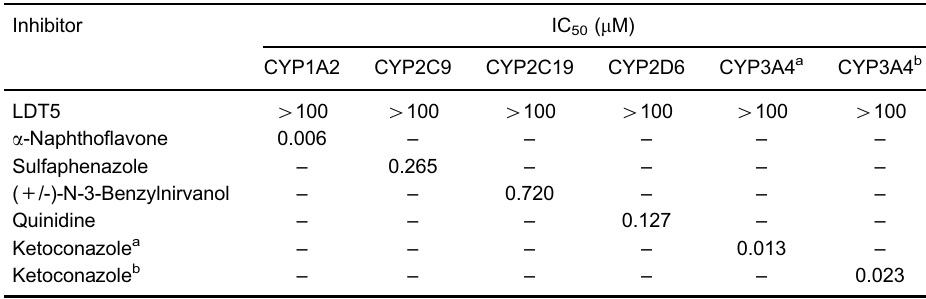
Table 3. In vitro results of the inhibition of various cytochrome P450 isozymes by LDT5 in human liver microsomes.